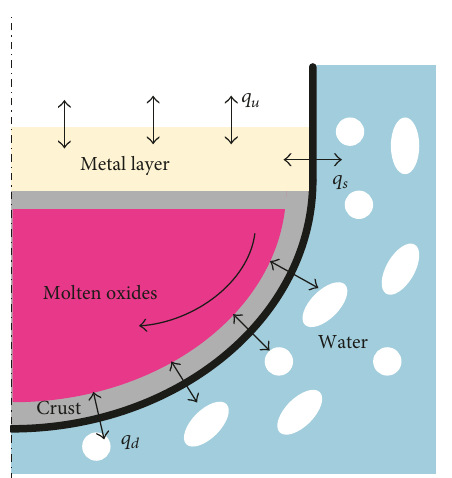
Figure 3: Arrangement of the molten pool in the lower head.